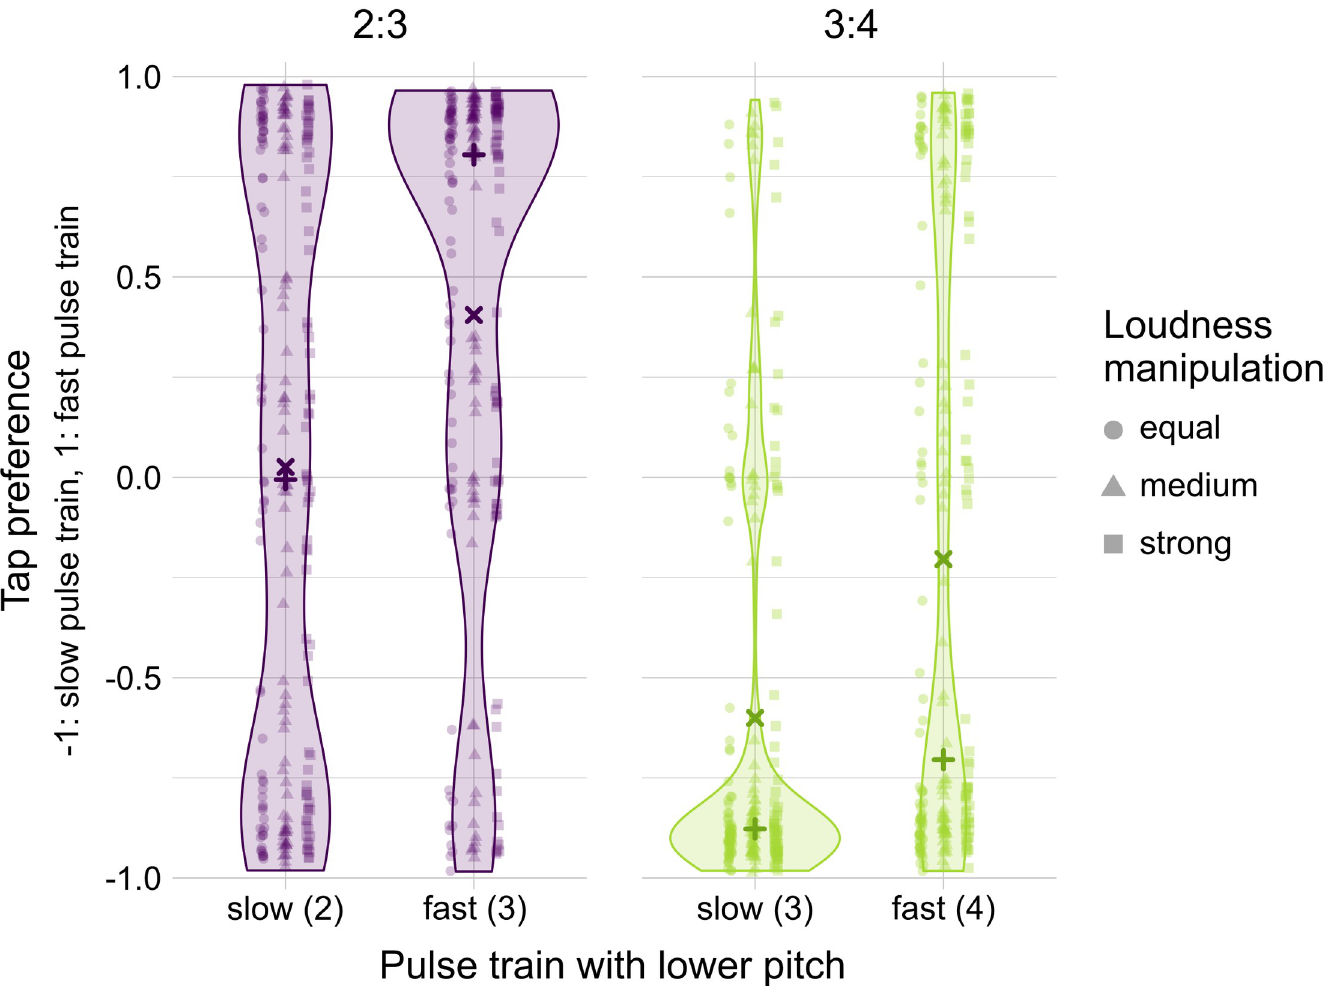
Fig 6. Tapping responses of the experiment manipulating the pitch of individual pulse trains. Individual data points per participant, pitch , and loudness condition of tapping preferences with 2:3 and 3:4 polyrhythms. Medians (+) and means (x) are computed over all loudness conditions. Values close to -1 indicate that participants consistently tapped in time with the slow pulse train, whereas values close to 1 indicate that participants consistently tapped in time with the fast pulse train.